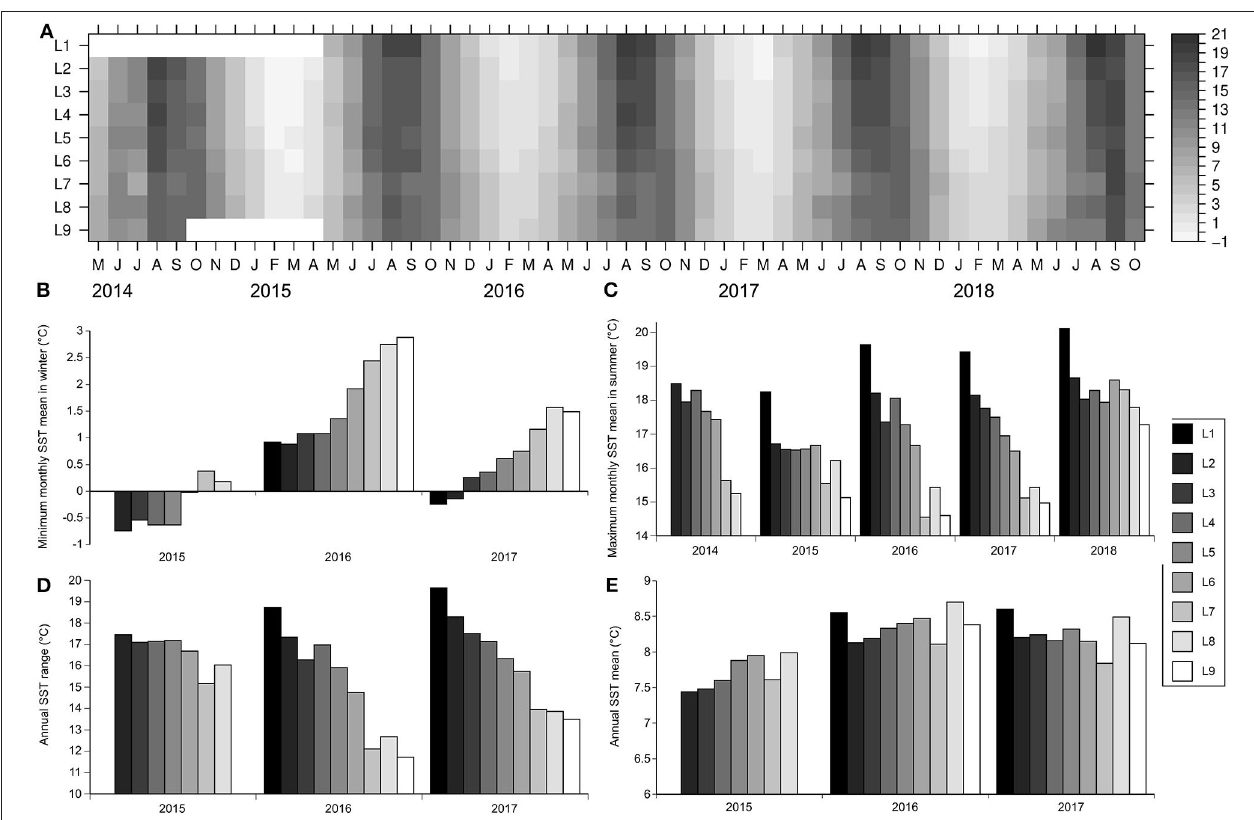
FIGURE 2 | (A) Heatmap indicating monthly mean SST ( ◦ C) for the nine intertidal locations (L1–L9) studied between May 2014 and October 2018 (no data are available between May 2014 and April 2015 for L1 and between October 2014 and April 2015 for L9), (B) minimum monthly SST means for winter months, (C) maximum monthly SST means for summer months, (D) annual SST ranges, and (E) annual SST means. See section Materials and Methods for the explanation of the locations and months that qualified for the comparisons shown in (B–E)